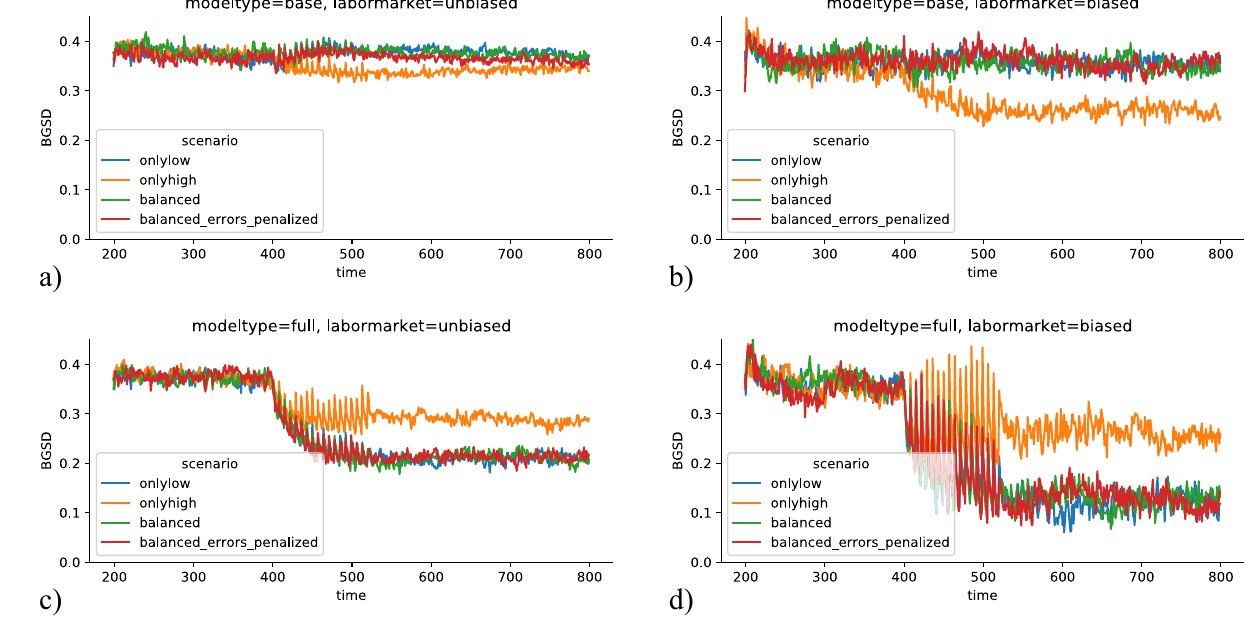
Figure 4. Time evolution of BGSD for all scenarios and all model combinations (full and base model, biased and unbiased prediction model). In an unbiased labor market and with the base prediction model, BGSD does not change significantly over time. Also, if the labor market is biased against the underprivileged group, BGSD does not change if the base prediction model is used, except if the help is targeted towards the high prospect group (scenario onlyhigh ). If the full prediction model is used, BGSD decreases in all scenarios, independent of whether the labor market is biased or unbiased.